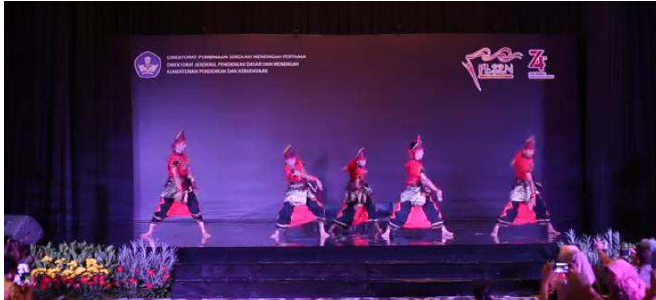
Figure 5. Male Group Participants from SMPN 1 Payakumbuh, received the 1st Place in the Province and proceed to